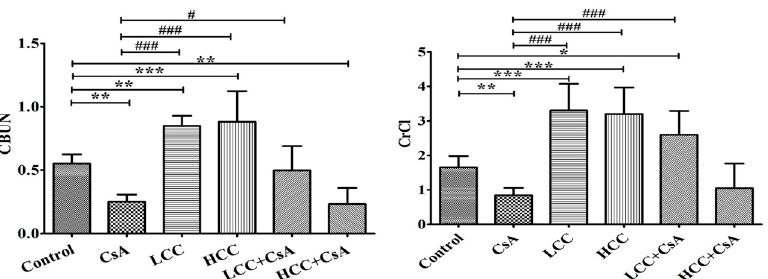
Figure 2. Effects of cyclosporine A (CsA) and CCM treatment on serum creatinine and urea levels. Control, CsA (10 mg/kg), LCC (40 mg/kg), HCC (400 mg/kg), LCC (40 mg/kg) + CsA (10 mg/kg), HCC (400 mg/kg) + CsA (10 mg/kg). Values are expressed as the mean ± SEM (n = 6). One-way analysis of variance (ANOVA) is followed by the Fisher’s protected least significant difference (LSD) tests. * p < 0.05, ** p < 0.01, and *** p < 0.001 vs. control. # p < 0.05 and ### p < 0.001 vs. CsA group.